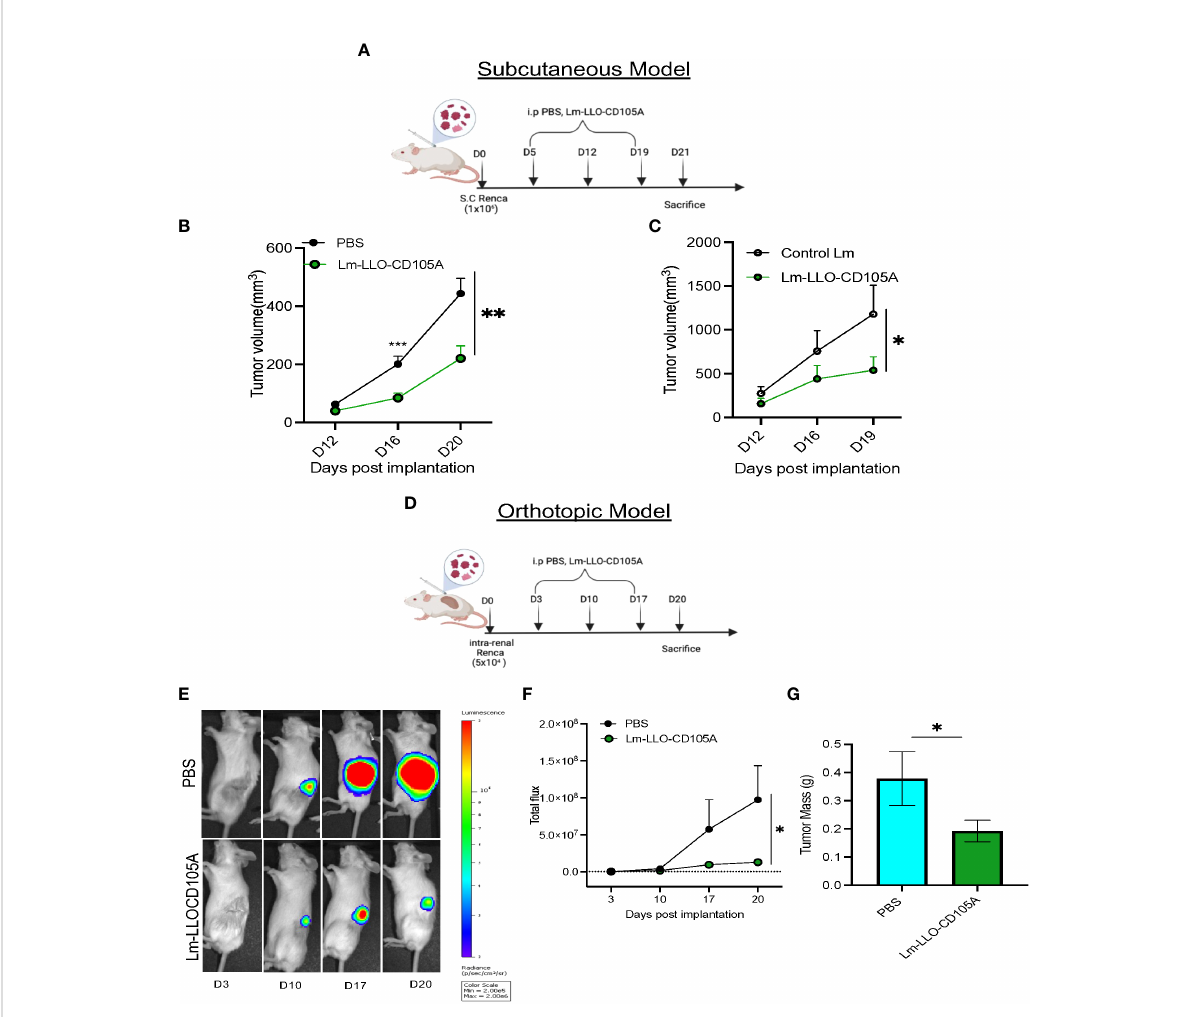
FIGURE 2 Lm-LLO-CD105 controls RCC tumor growth. (A) Vaccination schedule for subcutaneous tumor challenge. (B, C) Longitudinal tumor growth curve of subcutaneous tumor challenge (PBS n=16, Control Lm n=5, Lm-LLO-CD105A n=5-10). (D) Vaccination schedule for orthotopic tumor challenge. (E) Representative bioluminescence imaging of kidney tumor burden. (F) Graphical representation of longitudinal luciferase fl ux. (G) Final tumor mass (PBS n=10, Lm-LLO-CD105A n=10). Data were analyzed using unpaired t-test. *P < 0.05, **P < 0.01, ***P< 0.001. All error bars are shown as mean ± SEM. Vaccination schedule depiction was made in